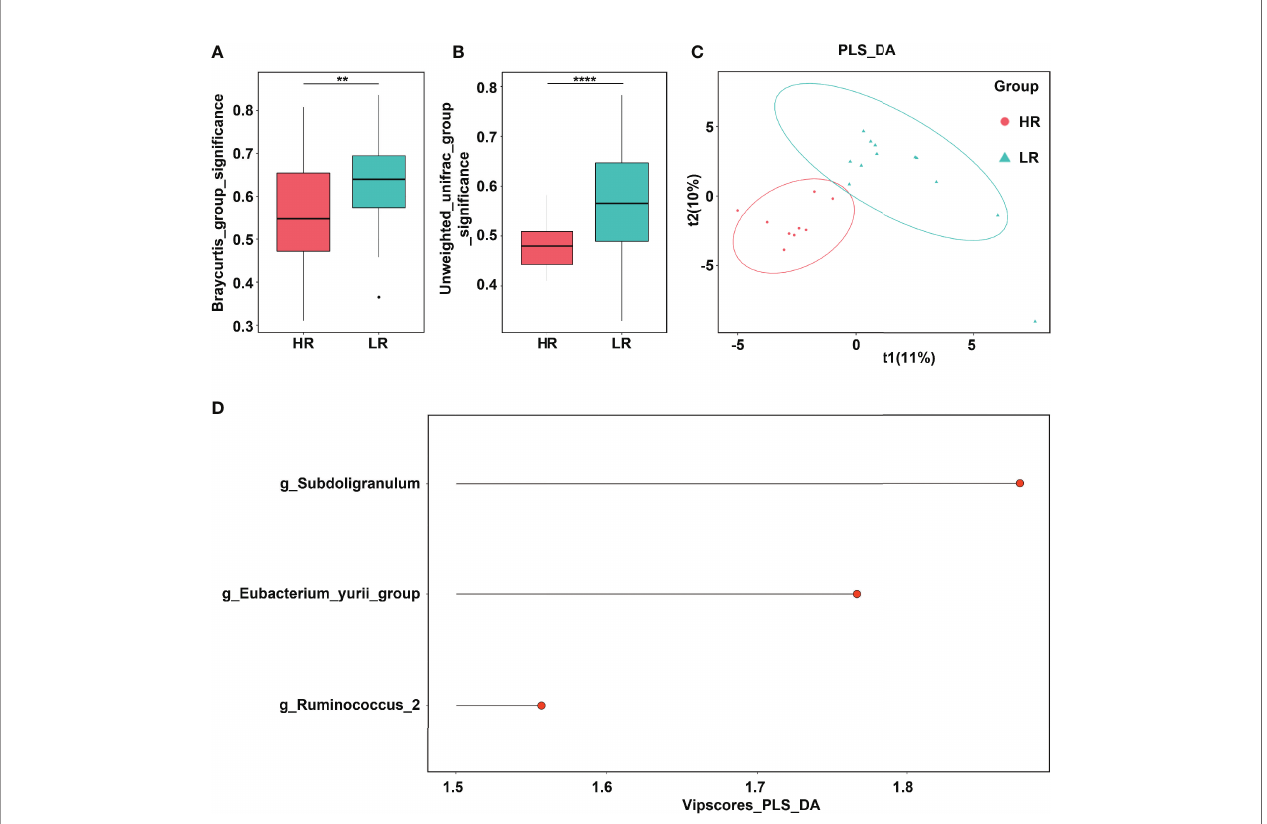
FIGURE 3 | Signi fi cant genera that contributed to response strength to mindfulness intervention. (A) Bray – Curtis distance. (B) Unweighted_unifrac distance. (C) PLS_DA analysis. (D) Signi fi cant genera with vipscore > 2 in PLS_DA analysis. ** means p value < 0.01; **** means p value <